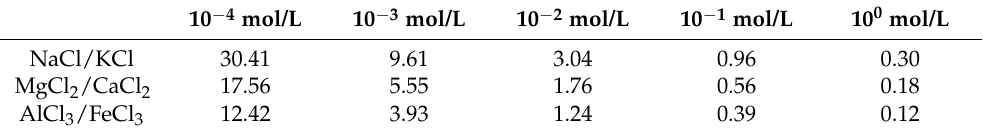
Table 1. The double-layer thickness of different electrolytes under different concentration (nm).